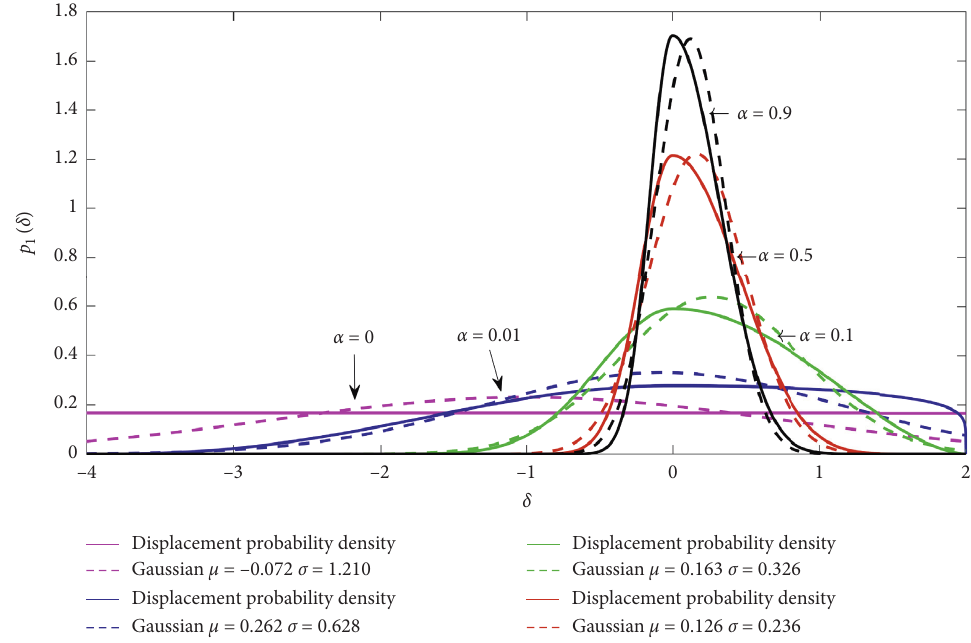
Figure 6: Displacement PDFs of ATNPS for different damping